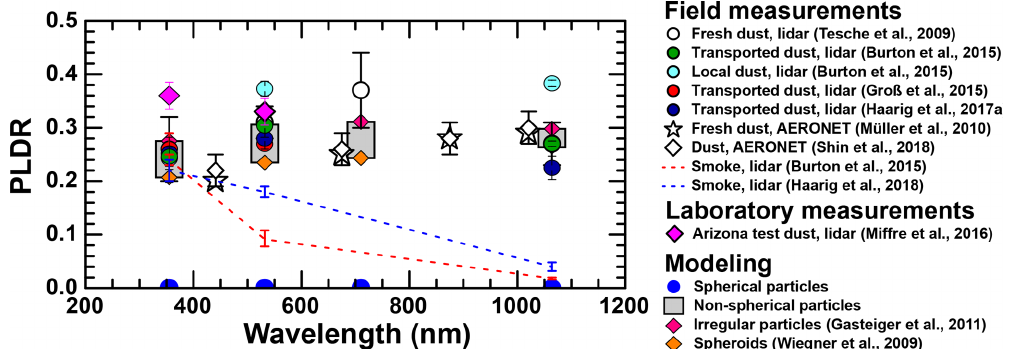
Figure 1. Overview of particle linear depolarization ratios for pure mineral dust from field measurements (Tesche et al., 2009a; Burton et al., 2015; Groß et al., 2015; Haarig et al., 2017a), laboratory studies (Miffre et al., 2016), AERONET observations (Müller et al., 2010; Shin et al., 2018), and modelling (Wiegner et al., 2009; Gasteiger et al., 2011). The use of Mie theory (spherical particles) gives values of zero. The range for modelling results is defined by the studies of Wiegner et al. (2009) (lower boundary, spheroids) and Gasteiger et al. (2011) (upper boundary, mixtures of irregularly shaped particles). The dashed blue and dashed red lines show that field measurements can reveal high depolarization ratios for biomass-burning smoke as well (Burton et al., 2015; Haarig et al.,